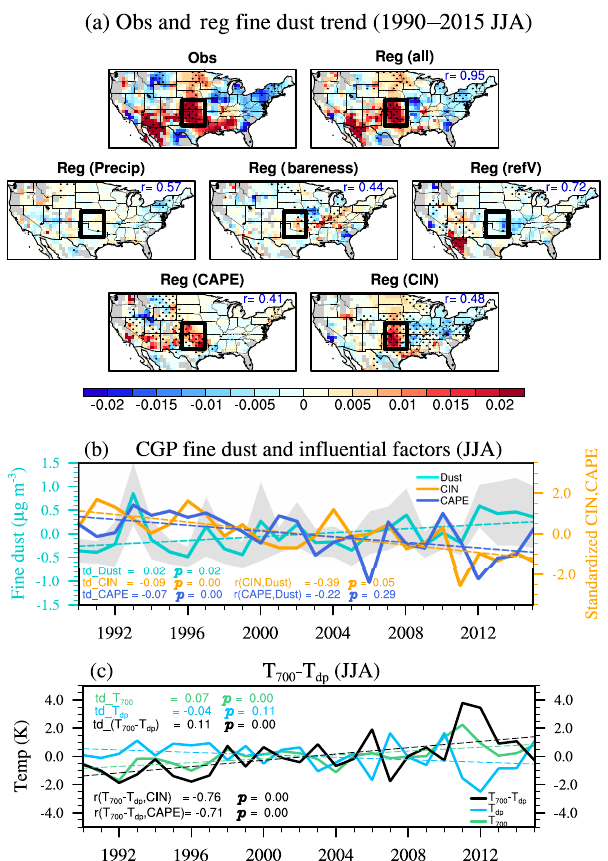
Figure 4. (a) Observed (Obs) and reconstructed (Reg) trends of fine dust concentration (µgm − 3 ) using five factors in summer from 1990–2015. The contributions from each factor (precipitation, bare- ness, surface wind, CAPE, and CIN) are also shown (second and third rows). Dotted areas are significant at the 90% confidence level. Pattern correlation between reconstructed dust concentration trends and the observed trends in the domain (25–49.5 ◦ N, 66.5– 125 ◦ W) are shown at the right corner of each plot. The black box denotes the central Great Plains (CGP). (b) Time series of fine dust concentration (cyan), CIN (orange), and CAPE (deep blue) aver- aged over the CGP and their linear trends (dashed lines) in summer from 1990 to 2015. Grey shading denotes ± 1 standard error of the observations. (c) Time series of T 700 − T dp (black), T 700 (green), and T dp (light blue) and their linear trends (dashed lines) in summer from 1990 to 2015.